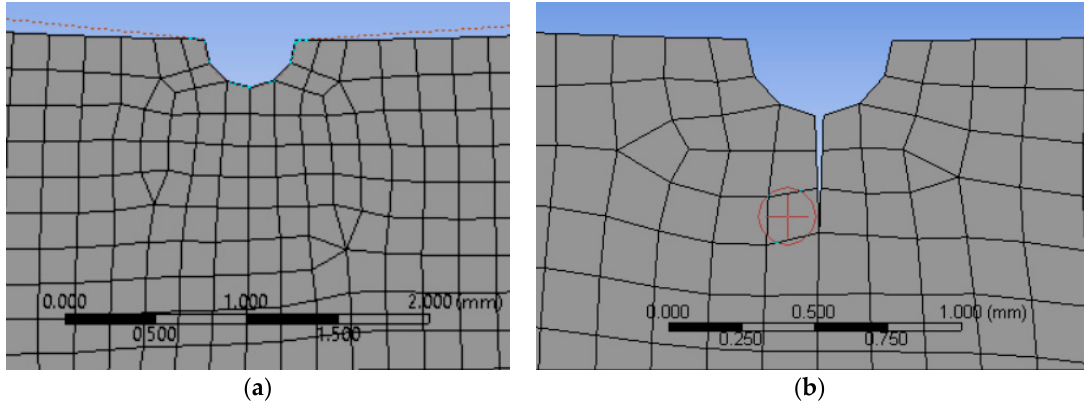
Figure 16. ( a ) 2D numerical model to evaluate SIF in mode I; ( b ) initial crack length of 400 μ